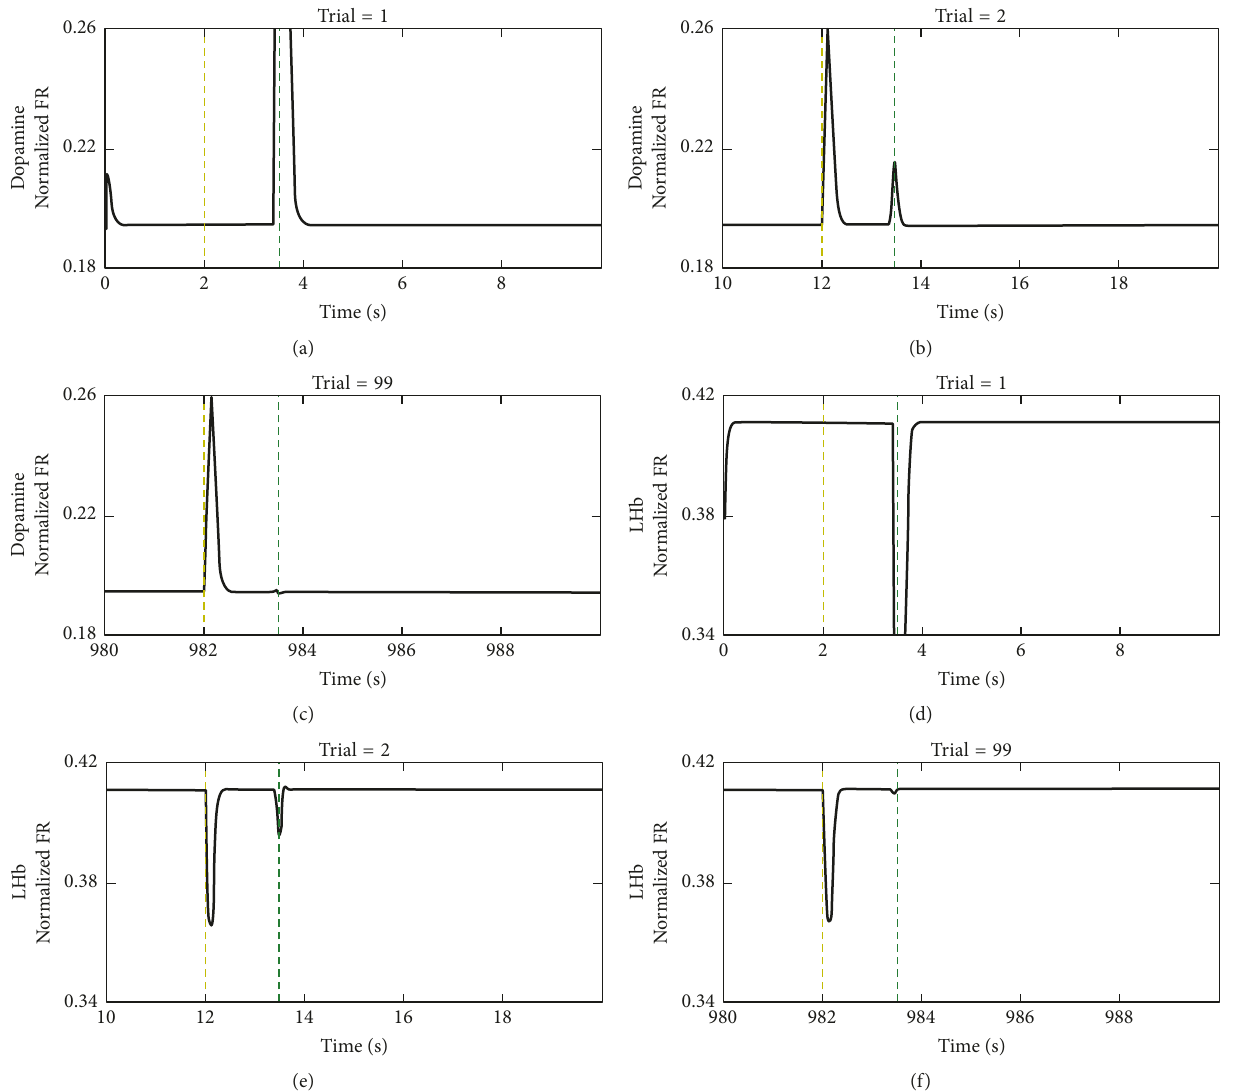
Figure 4: The shift of DA and LHb neurons’ responses from US to CS. At the beginning of our simulation, the model circuit receives a reward CS and a reward US. FR: neural firing-rate activity. (a) Response of dopamine neurons in the 1st trial: DA neurons exhibit a phasic peak upon US before learning and do not respond to CS. (b) Response of DA neurons in the 2nd trial: the activity of DA neurons shows a peak upon CS and a peak upon US. The response upon US is weaker than the response in the 1st trial. The responses of DA neurons in the 3rd to 98th trials are similar to (b), but the peak upon US gets weaker over trials. (c) Response of DA neurons in the 99th trial: the activity of DA neurons shows a peak upon CS, but baseline responding to US after learning. (d) Response of LHb neurons in the 1st trial: LHb neurons exhibit a phasic dip upon US before learning and do not respond to CS. (e) Response of LHb neurons in the 2nd trial: the activity of LHb neurons shows a dip upon CS and a dip upon US. The response upon US is weaker than the response in the 1st trial. The responses of DA neurons in the 3rd to 98th trials are similar to (e), but the dip upon US gets weaker trial by trial. (f) Response of LHb neurons in the 99th trial: the activity of LHb neurons shows a dip upon CS, but baseline responding to US after learning. (a), (b), and (c) show the shift of DA neural response from US to CS after learning, while (d), (e), and (f) show the shift of LHb neural response. The yellow dashed line indicates the time at which CS appears and the green dashed line indicates the time at which rewards are released or